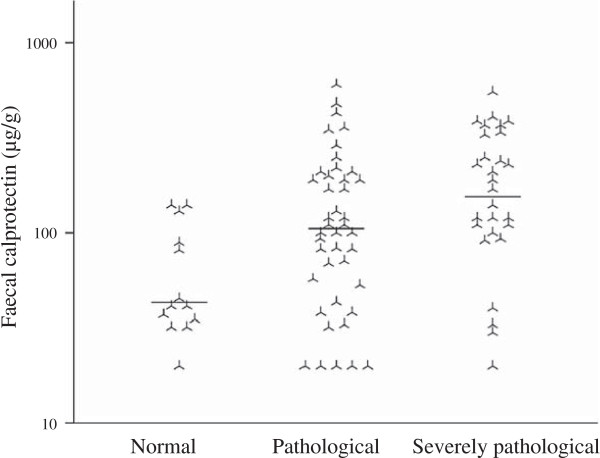
In systemic sclerosis, faecal calprotectin is associated with pathological cineradiograhy. Individual and median faecal calprotectin levels in systemic sclerosis patients with different degrees of pathological cineradiographies. 1-way analysis of variance, P = 0.007. Please note the logarithmic scale on the y-axis.